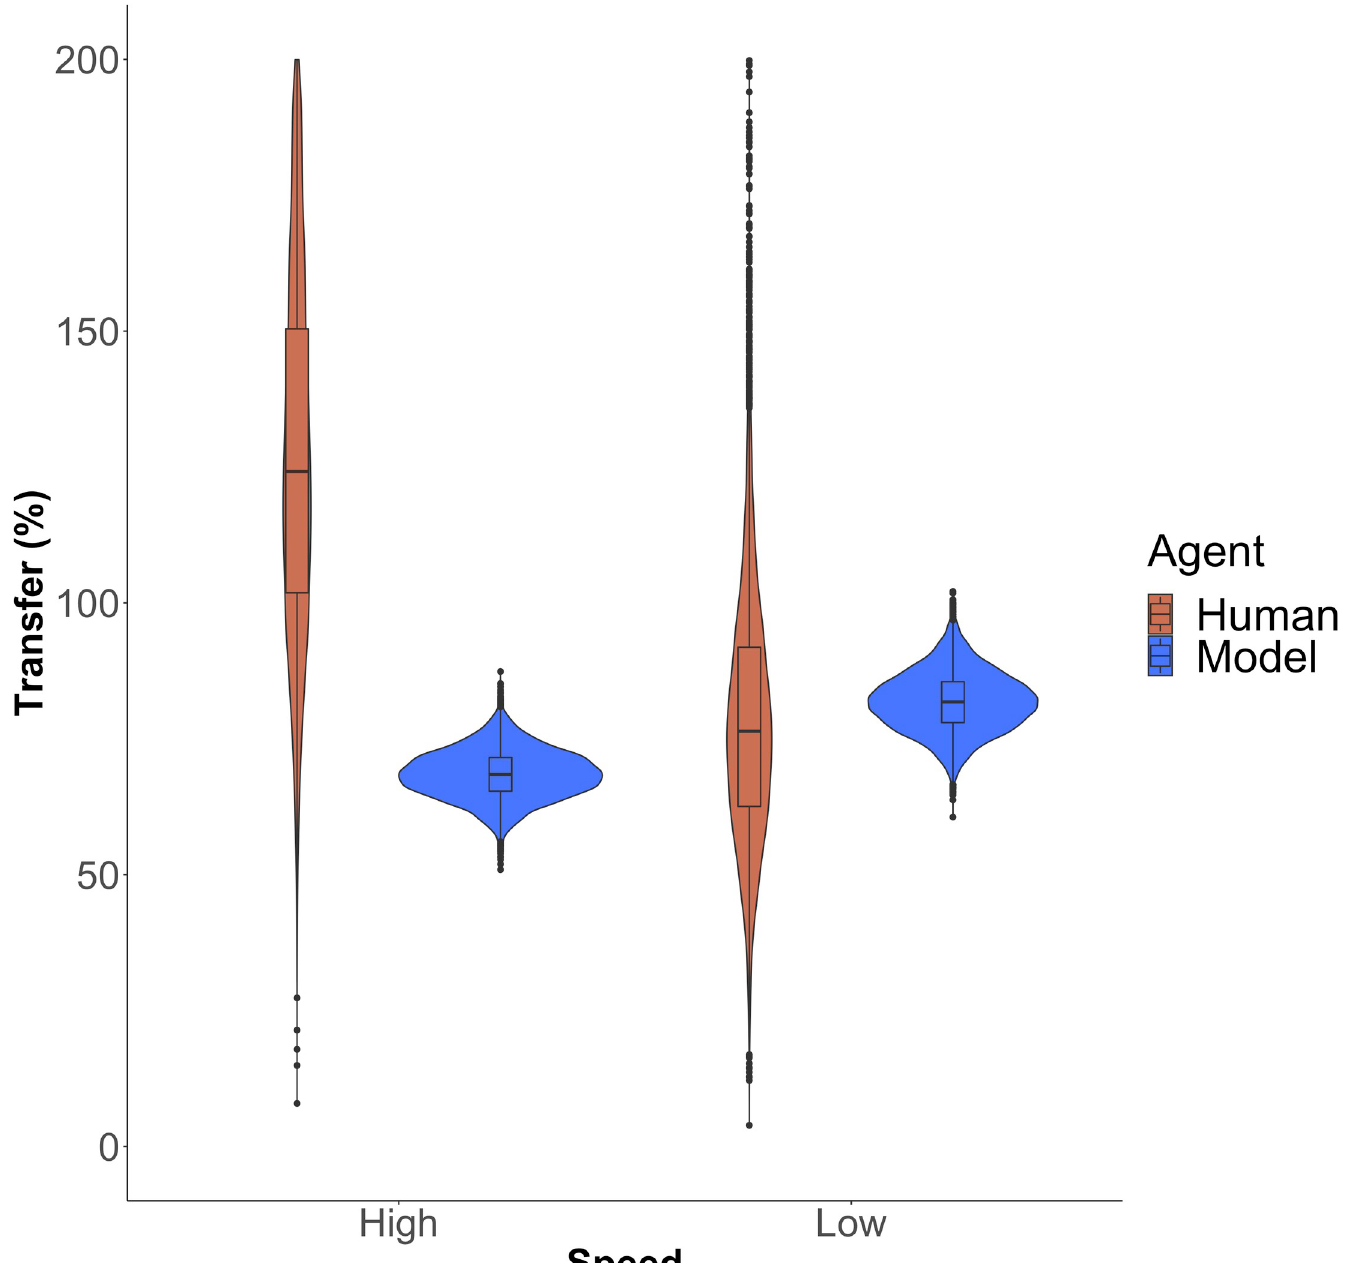
Fig 7. Human and model bootstrapped transfer levels at high and low speeds. The violin plot displays the frequency distribution of bootstrapped transfer levels (%) in humans (brown) and in the ACT-R model with two trackers and one temperature (blue). For each speed (high vs. low), a boxplot indicates the transfer median, first quartile and third